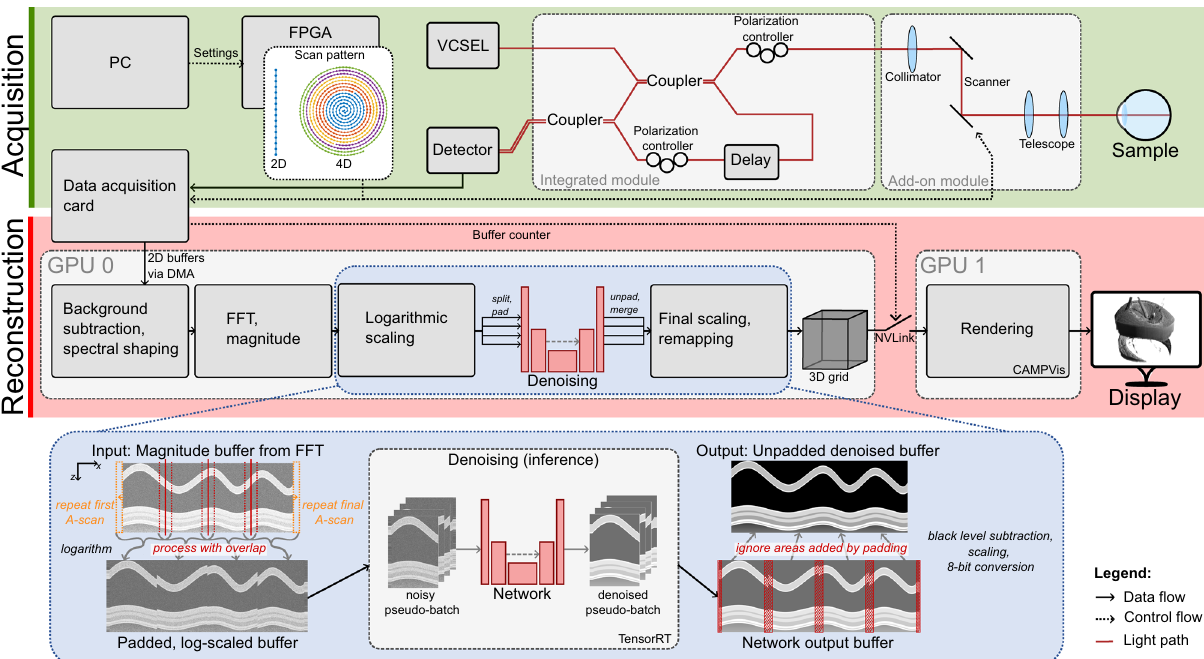
Figure 1. Overview of the 4D-OCT prototype including denoising. Denoising is incorporated into the processing pipeline of two-dimensional buffers, executed on a GPU. Size, number and spatial origin of buffers vary depending on the imaging mode, as indicated by different colors in the scan patterns. The buffer processing for denoising, including splitting into four sub-buffers and padding for pseudo-batching, is visualized in the